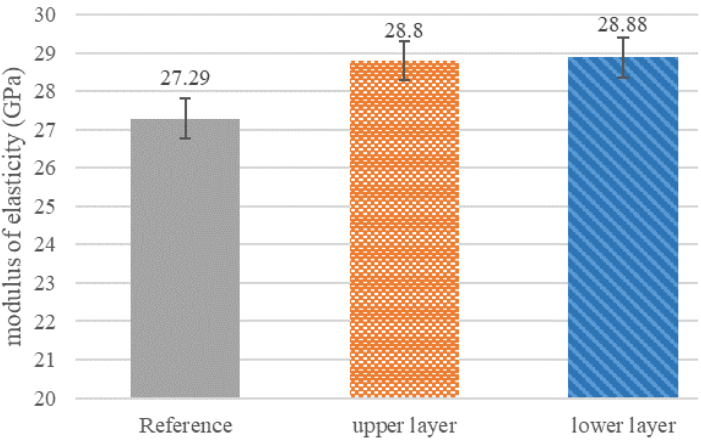
Figure 6. Modulus of elasticity of concrete at 28 days